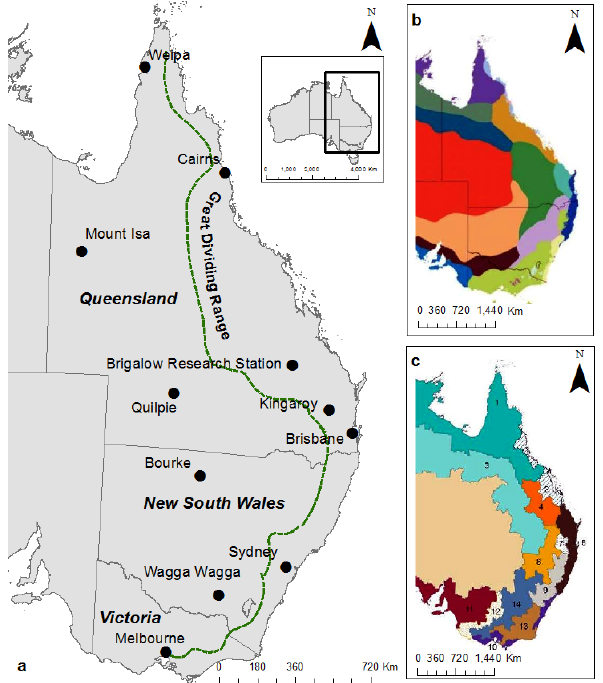
Figure 1. (a) Selected locations of interest with boundaries of (b) agro-climatic classes (Hutchinson et al., 2005) and (c) Aus- tralian agricultural environments (Woodhams et al.,